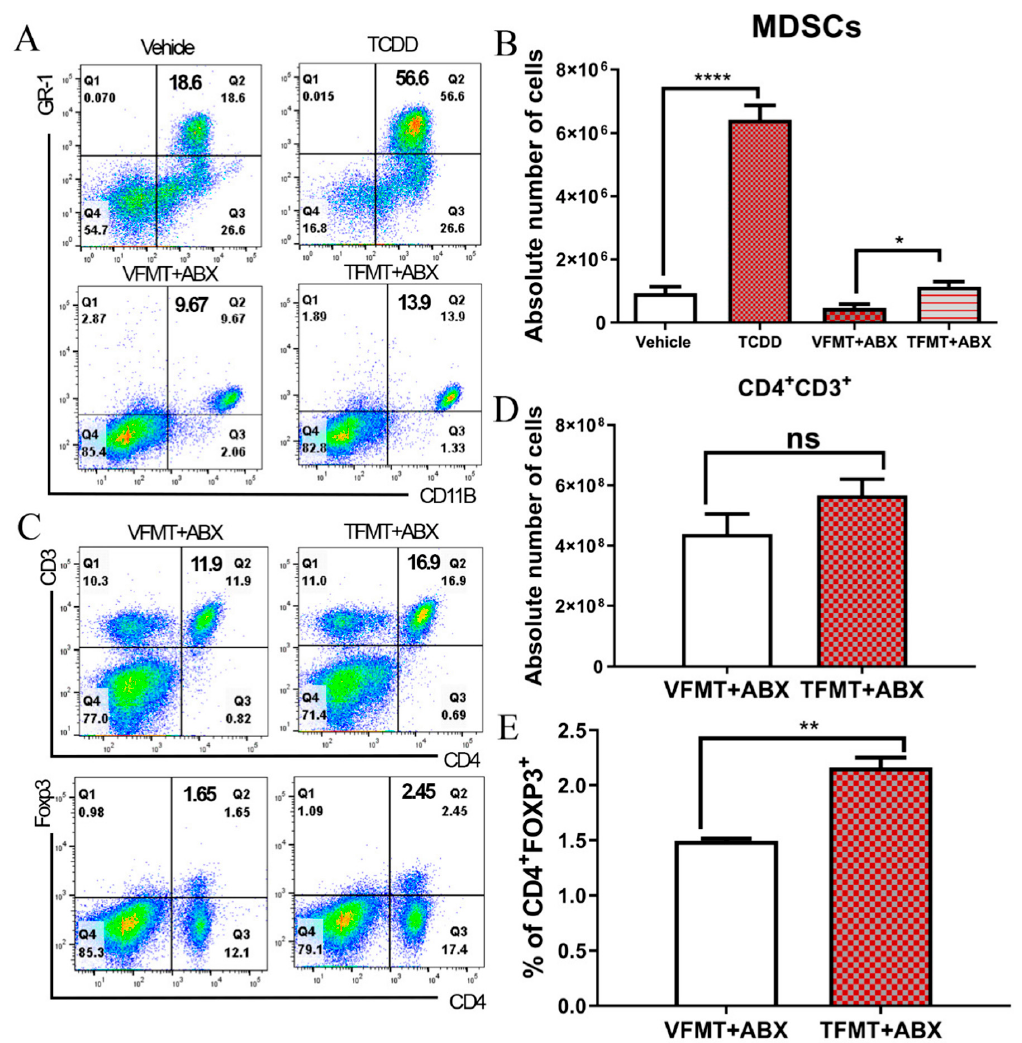
Figure 2. Effect of fecal microbiota transplantation (FMT) on myeloid derived-suppressor cells MDSCs and regulatory T-cells (Tregs). ( A , B ) Naïve C57BL6 mice received either the vehicle ( n = 6) or